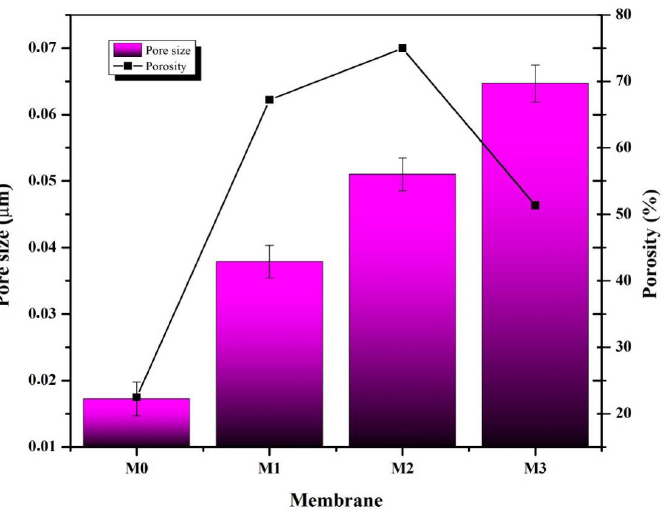
Figure 5. Effect of polymer composition on the membrane porosity and pore size. The membrane sample was immersed in water for 24 h at room temperature. Membrane porosity and pore size were calculated using Equations (2) and (3).